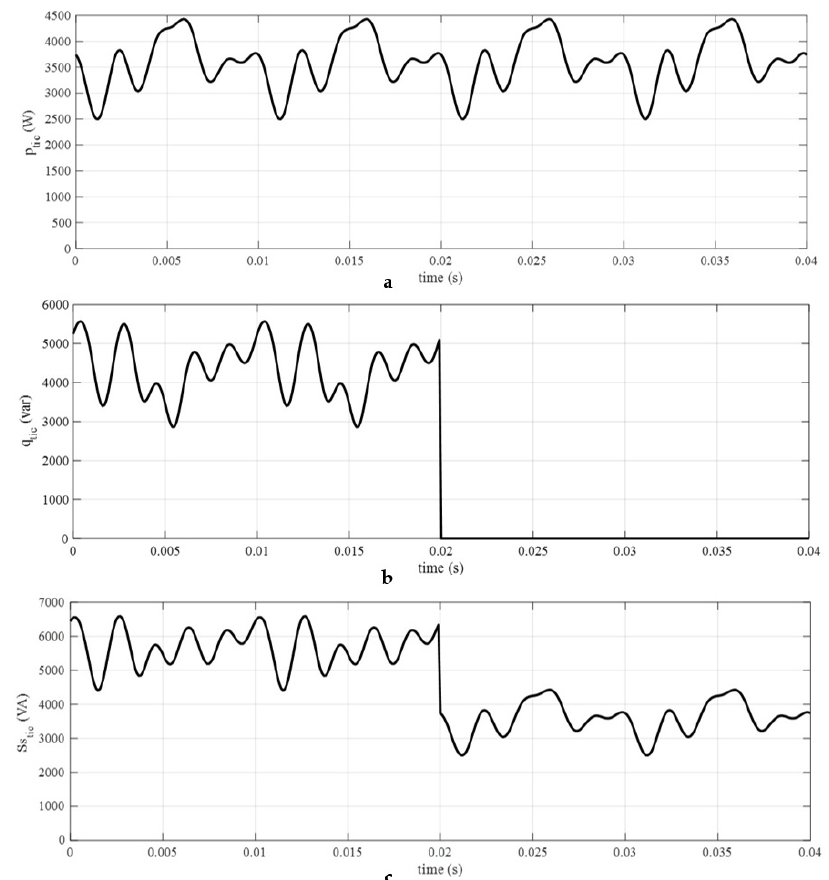
Figure 6. Power variables before/after TIC (t = 0.02 s): ( a ) instantaneous power, ( b ) instantaneous reactive power, ( c ) norm of the instantaneous power multivector. The balance of the power variables before and after TAC is presented in Figure